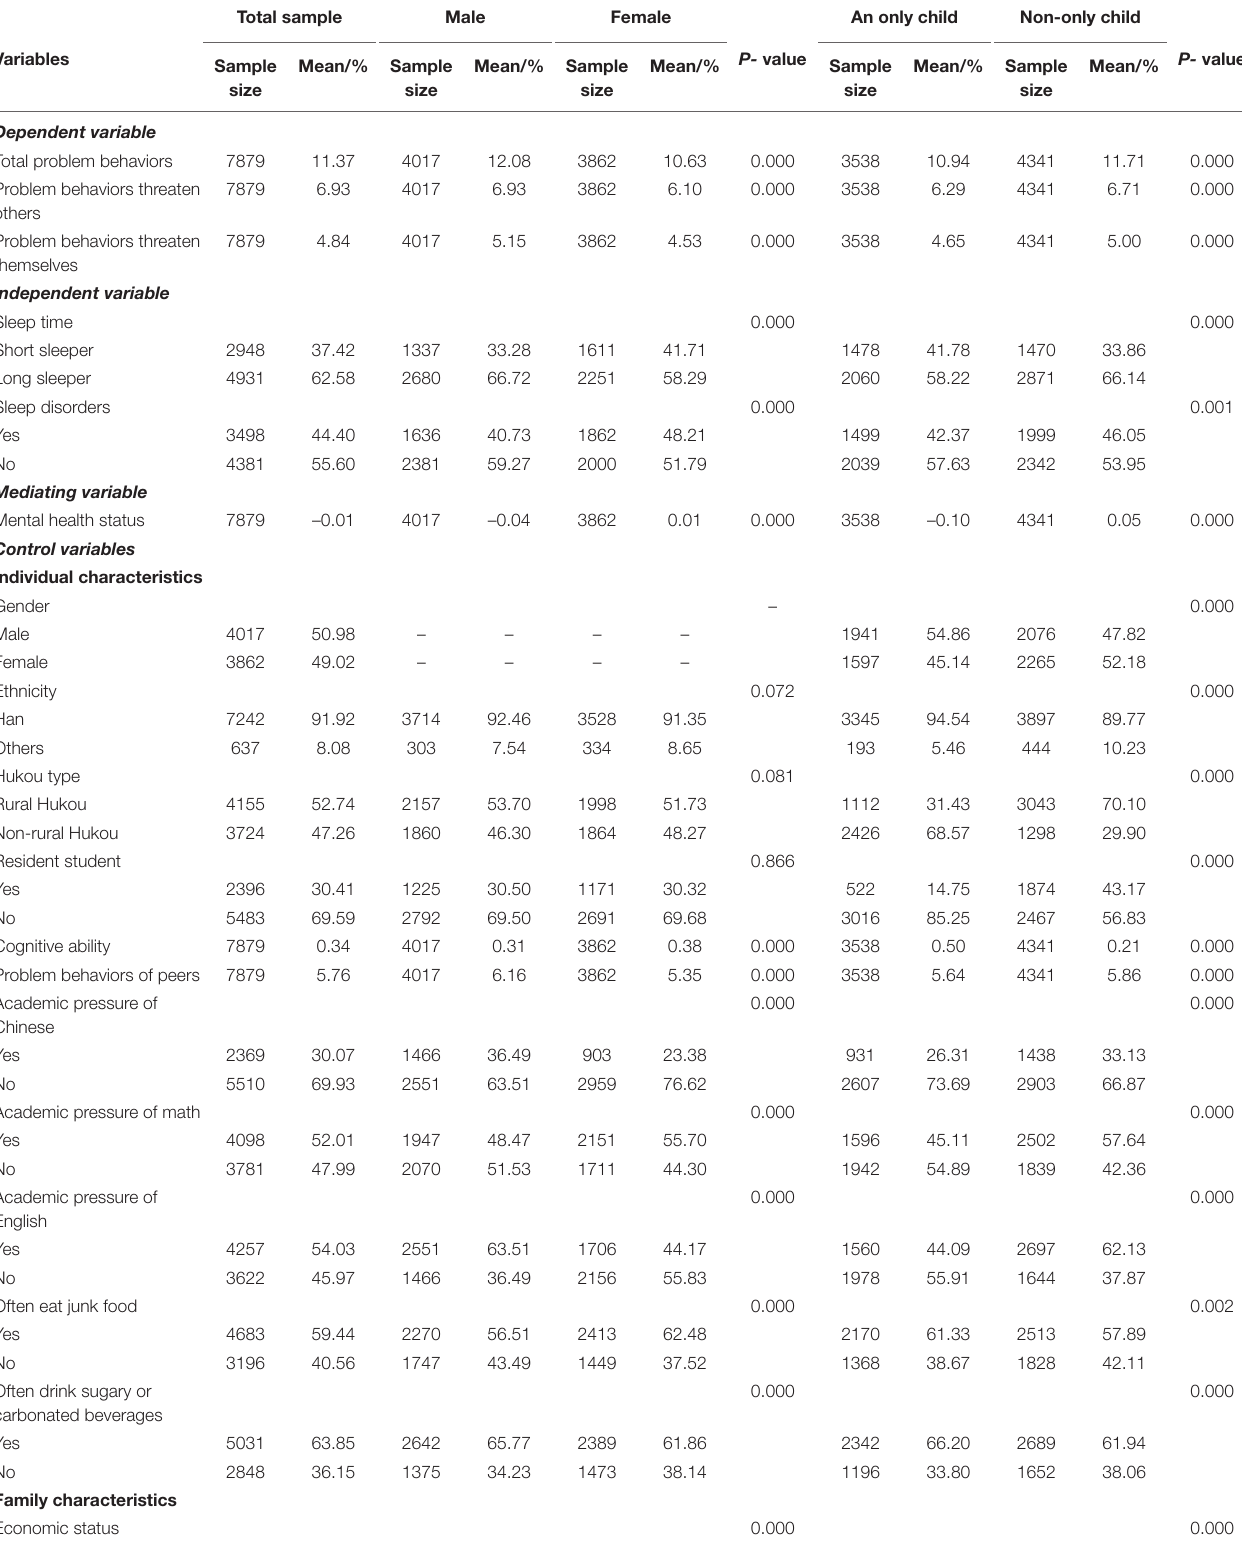
TABLE 1 | Descriptive